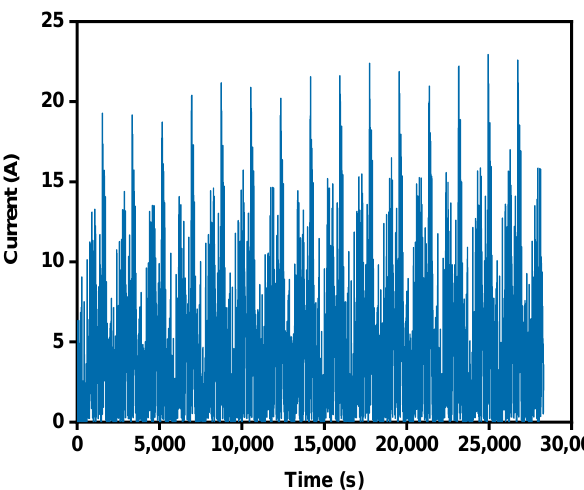
Figure 12. The profile of current in the entire discharge process of a single battery under 15.7 WLTCs.